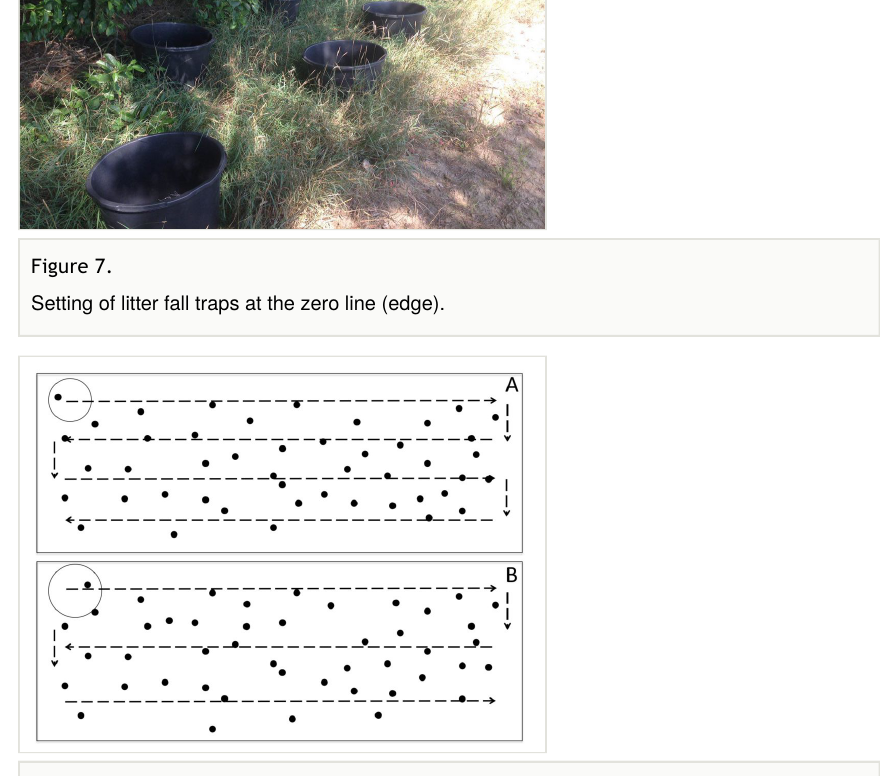
Litterfall was measured with buckets (see Fig. 7) of 52 cm inner diameter resulting in an area of ca. 0.21 m per bucket trap fall. Per distance (0 m, 35 m and 70 m; Figs 1, 2), n =10 litter fall traps were used. Sampling was conducted from September 2016 to May 2017 at fi ve dates (13th Sept., 10th Oct., 7th Nov., 10th Jan., 22nd May). After each sampling, the needles of larch ( Larix decidua ) at the west-facing site and pine ( Pinus sylvestris L.) at the east-facing site were oven-dried for 48 h at 65°C and, subsequently, dry mass was determined by weighing (Suppl. material 5). The samples also comprised small amounts of other biomass.